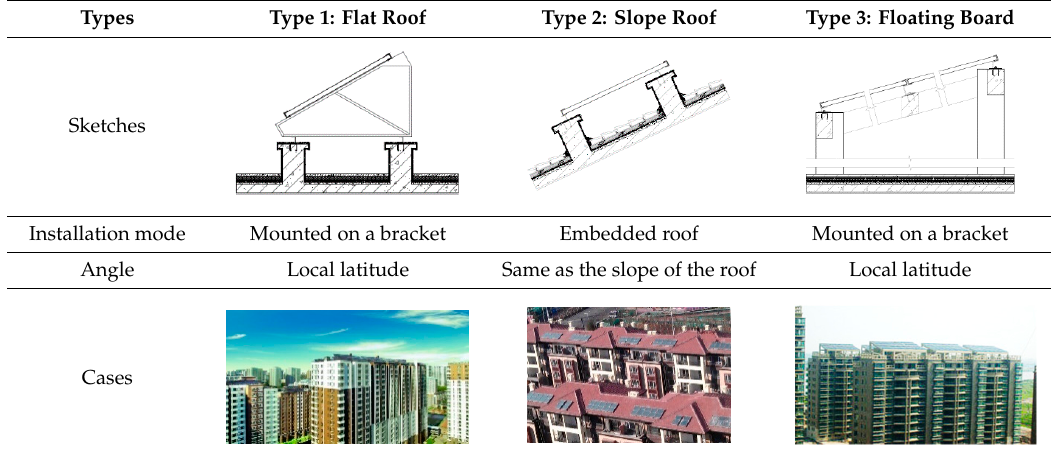
Table 4. Solar collectors installation modes on roofs.